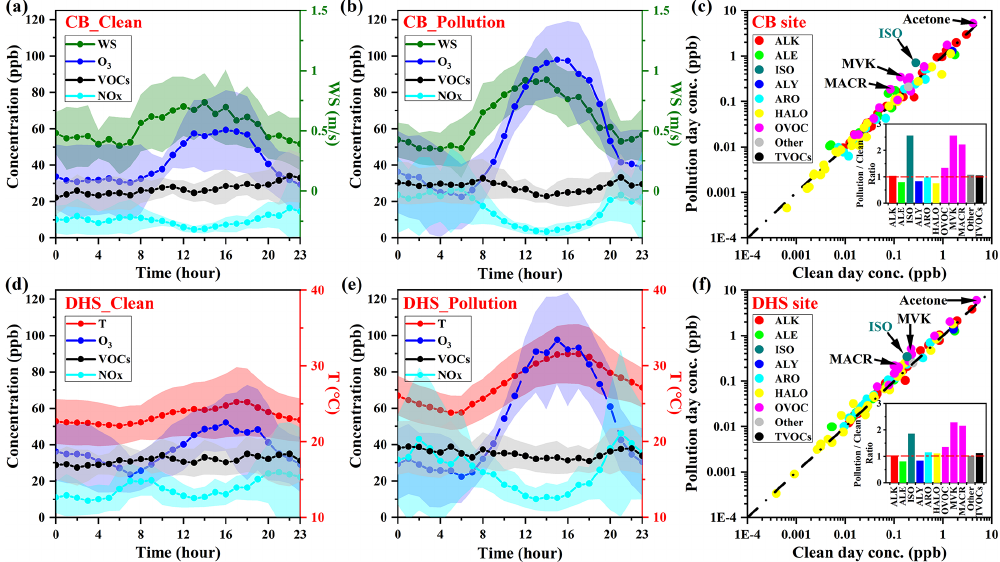
Figure 3. Diurnal variations in wind speed (WS), temperature ( T ), O 3 , NO x , and TVOCs on clean and polluted days at the (a, b) CB and (d, e) DHS sites. Differences in VOC concentrations between clean and polluted days at the (c) CB and (f) DHS sites. ALK: alkanes; ALE: alkenes (except isoprene); ISO: isoprene; ALY: alkynes; ARO: aromatics; HALO: halohydrocarbons; MVK: methyl vinyl ketone; MACR: